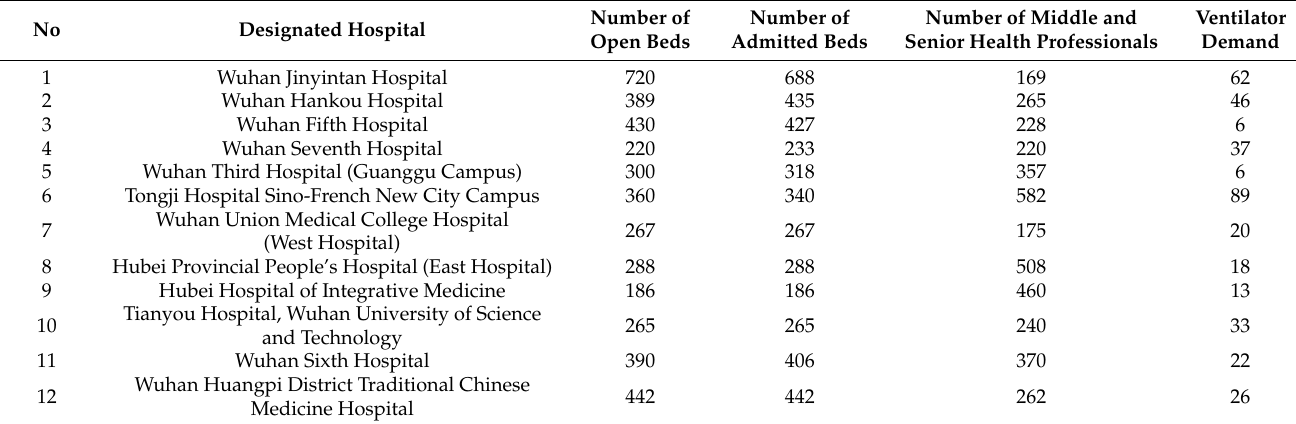
Table 5. Information of each medical equipment demand